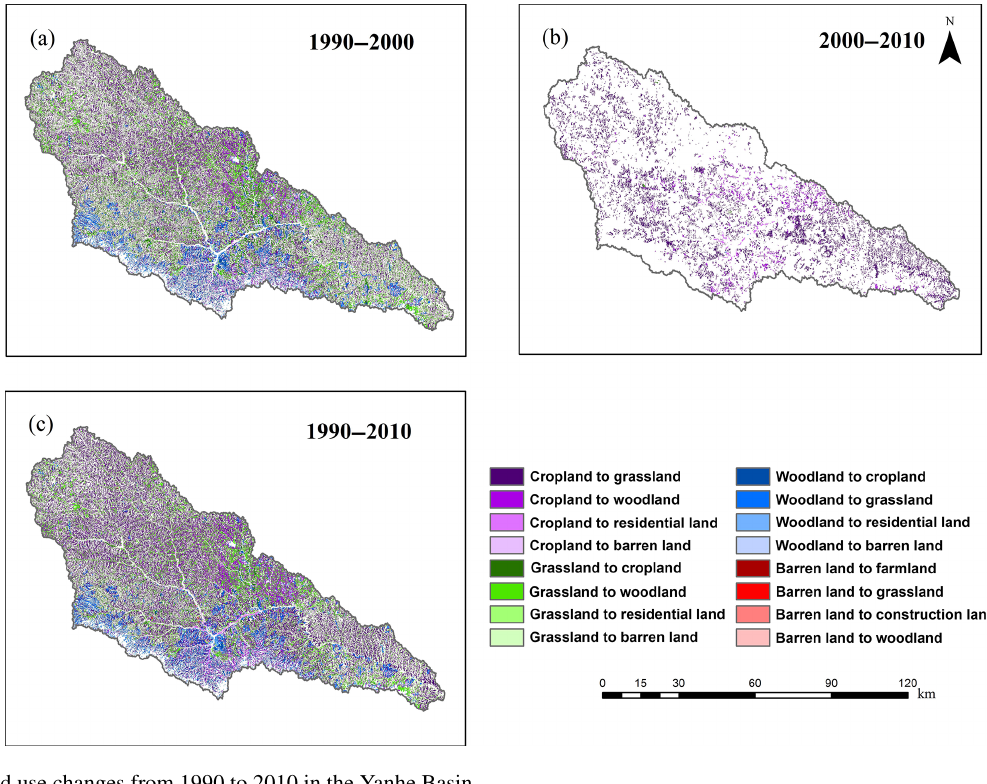
Figure 4. Land use changes from 1990 to 2010 in the Yanhe Basin.